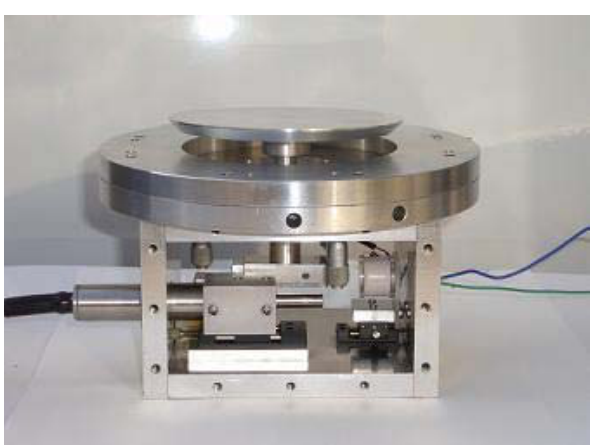
Schematic view experimental setup